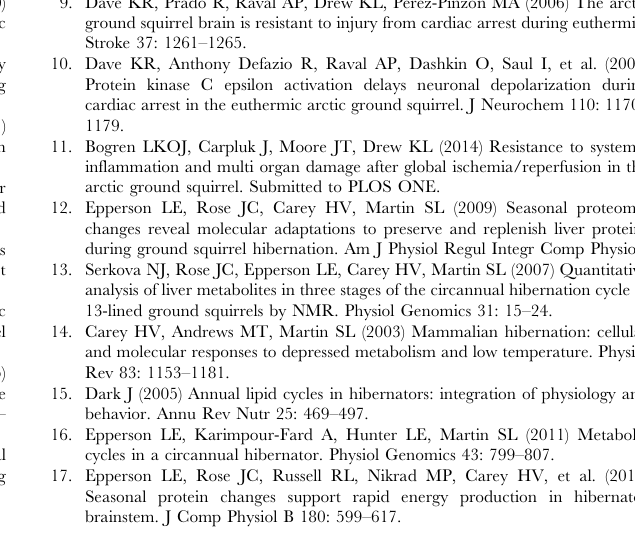
Figure S2 H-C-HMQC verifying the identity of Acetate at 1.91 ppm, from extracted naı¨ve rat sample to aid in peak identification. Figure S3 1 H–CPMG of unprocessed rat plasma. (TIF) Figure S4 H-H-COSY of hydrophilic fraction of extract- ed naive rat sample to aid in peak identification. Figure S5 H-H-COSY of hydrophilic fraction of extract- ed naive rat sample to aid in peak identification. Figure S6 H-C-HMQC of hydrophilic fraction of ex- tracted naive rat sample to aid in peak identification. Figure S7 H-C-HMQC of hydrophilic fraction of ex- tracted naive rat sample to aid in peak identification. Figure S8 H-C-HMQC of hydrophilic fraction of ex- tracted naive rat sample to aid in peak identification. Figure S9 1 H–CPMG of unprocessed AGS plasma to aid in peak identification. Figure S10 H-C-HSQC from unprocessed AGS plasma to aid in peak identification.